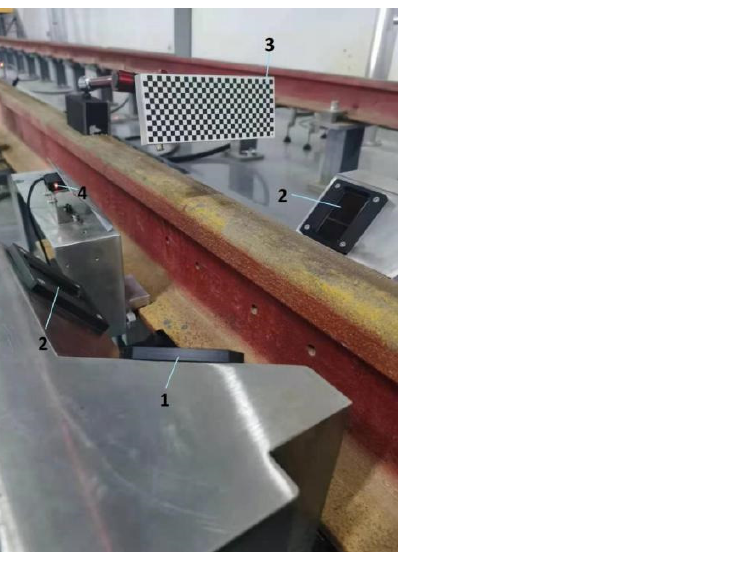
Figure 11. The arrangement of calibration. (1) Camera window; (2) laser window; (3) calibration board; (4) photoelectric switch. Table 1. Calibration polynomial coefficients of the proposed method.